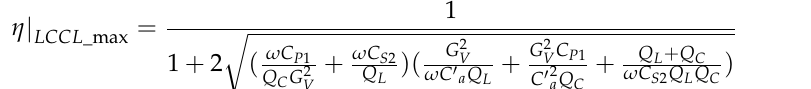
The optimum load resistance to achieve the maximum system efficiency is calculated as follows.